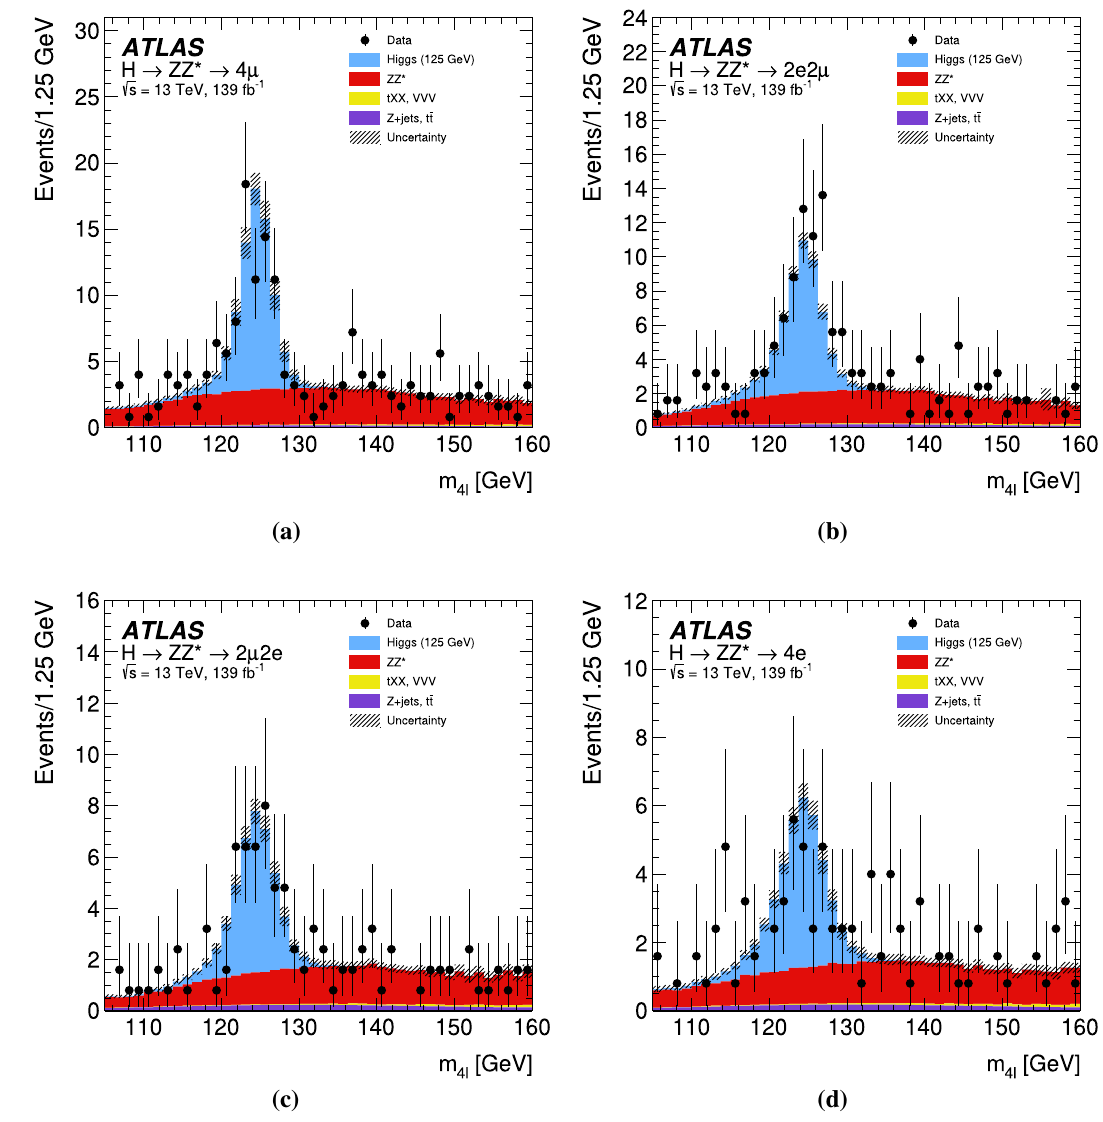
Fig. 3 The observed and expected (pre-fit) four-lepton invariant mass distribution for the selected Higgs boson candidates, for the different decay final states a 4 μ , b 2 e 2 μ , c 2 μ 2 e , d 4 e . The uncertainty in the